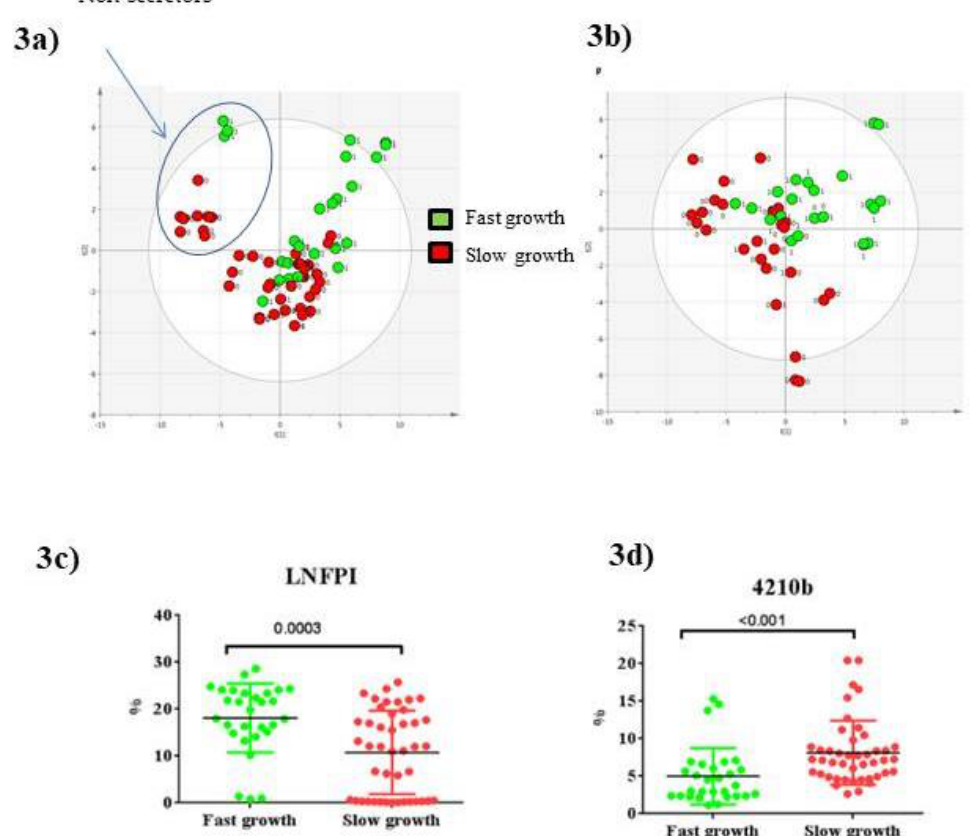
Figure 3. PLS-DA score plot based on the LC- HRMS glycomics profiles of human preterm milk of all mothers ( a ) (with non-secretor mothers circled on the basis of on the concentration of 2’-FL in their milks) or only of secretor mothers ( b ), on the factor weight Z -score (discharge-birth) with 45–39% of variance (R2Y = 37–45%), respectively, on components 1–2. Scatter plot (median) from W2 to W4 of lactation period (with secretor and non-secretor mothers) for two representative HMOs selected among VIP of interest: LNFPI ( c ) and 4210b ( d ), respectively. P values for comparison between “faster” and “slower” growth groups were derived using Mann-Whitney U test.